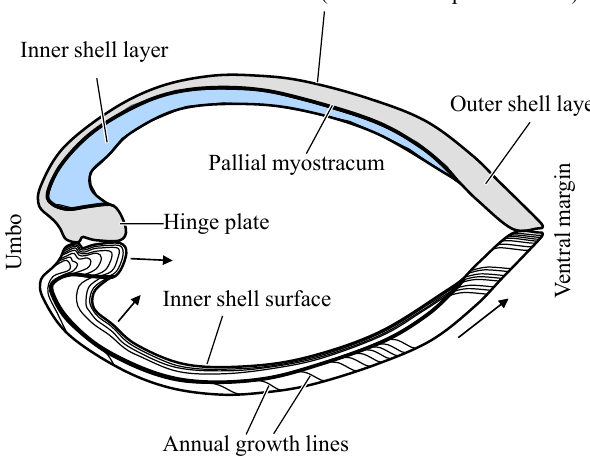
Figure A1. Morphological characteristics of the shell of the bivalve Arctica islandica . A detailed description is given in Schöne (2013).